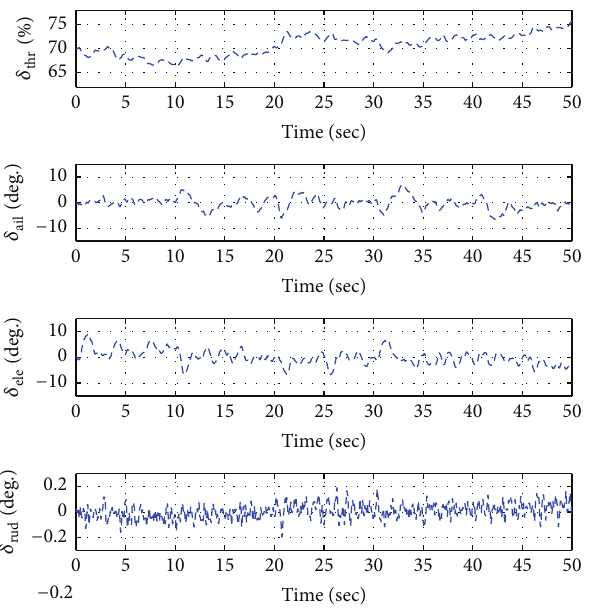
Figure 21: Time histories of control inputs at transition mode (Case 2). Transition mode (5m/s).